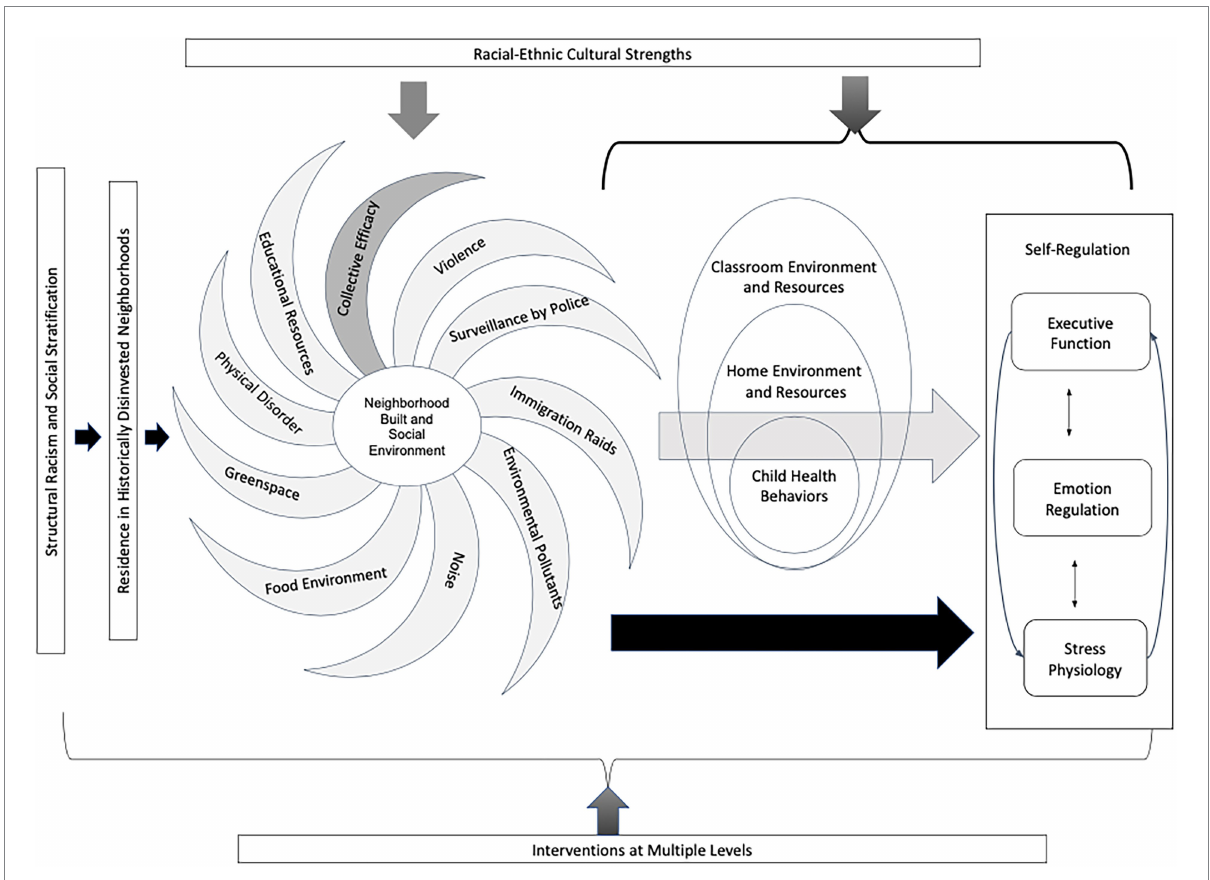
FIGURE 1 Conceptual model of built and social environment influences on the development of early childhood self-regulation in historically disinvested